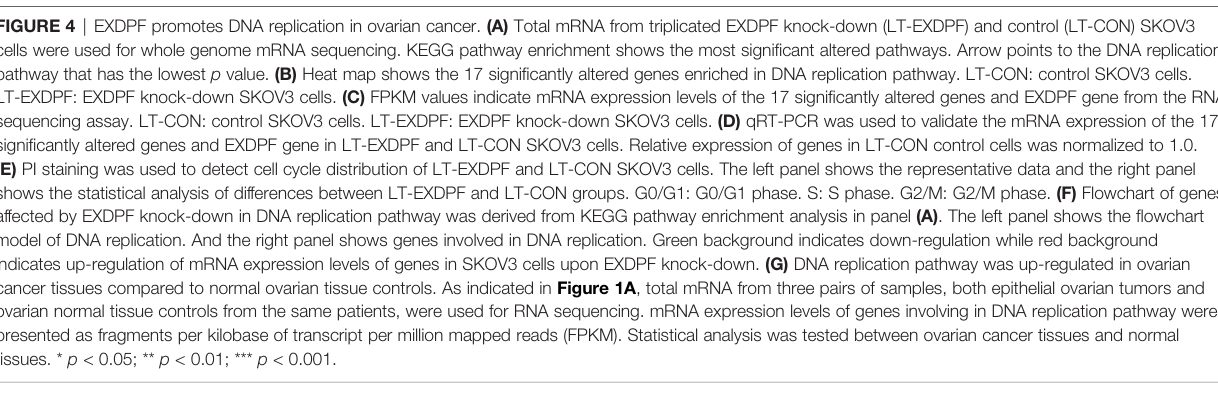
FIGURE 4 | EXDPF promotes DNA replication in ovarian cancer. (A) Total mRNA from triplicated EXDPF knock-down (LT-EXDPF) and control (LT-CON) SKOV3 cells were used for whole genome mRNA sequencing. KEGG pathway enrichment shows the most signi fi cant altered pathways. Arrow points to the DNA replication pathway that has the lowest p value. (B) Heat map shows the 17 signi fi cantly altered genes enriched in DNA replication pathway. LT-CON: control SKOV3 cells. LT-EXDPF: EXDPF knock-down SKOV3 cells. (C) FPKM values indicate mRNA expression levels of the 17 signi fi cantly altered genes and EXDPF gene from the RNA sequencing assay. LT-CON: control SKOV3 cells. LT-EXDPF: EXDPF knock-down SKOV3 cells. (D) qRT-PCR was used to validate the mRNA expression of the 17 signi fi cantly altered genes and EXDPF gene in LT-EXDPF and LT-CON SKOV3 cells. Relative expression of genes in LT-CON control cells was normalized to 1.0. (E) PI staining was used to detect cell cycle distribution of LT-EXDPF and LT-CON SKOV3 cells. The left panel shows the representative data and the right panel shows the statistical analysis of differences between LT-EXDPF and LT-CON groups. G0/G1: G0/G1 phase. S: S phase. G2/M: G2/M phase. (F) Flowchart of genes affected by EXDPF knock-down in DNA replication pathway was derived from KEGG pathway enrichment analysis in panel (A) . The left panel shows the fl owchart model of DNA replication. And the right panel shows genes involved in DNA replication. Green background indicates down-regulation while red background indicates up-regulation of mRNA expression levels of genes in SKOV3 cells upon EXDPF knock-down. (G) DNA replication pathway was up-regulated in ovarian cancer tissues compared to normal ovarian tissue controls. As indicated in Figure 1A , total mRNA from three pairs of samples, both epithelial ovarian tumors and ovarian normal tissue controls from the same patients, were used for RNA sequencing. mRNA expression levels of genes involving in DNA replication pathway were presented as fragments per kilobase of transcript per million mapped reads (FPKM). Statistical analysis was tested between ovarian cancer tissues and normal tissues. * p < 0.05; ** p < 0.01; *** p